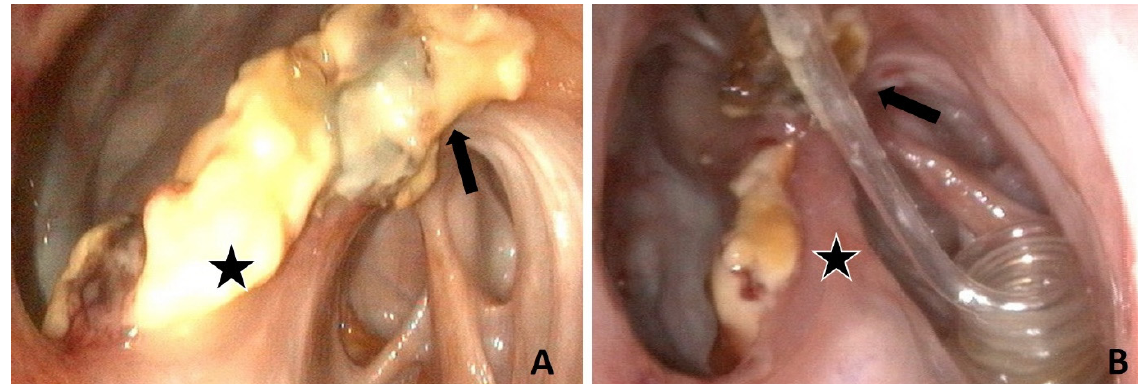
Figure 6. Endoscopic evaluation of Horse 6, right GP (guttural pouch): ( A ) at admission, macroscopic inflammatory lesions located on the stylohyoid bone (star) and the roof the medial compartment with regard to the ICA (internal carotid artery) (arrow); ( B ) after 9 days of TOT (topical oxygen therapy) and a TACE (transarterial coil embolization) procedure, the volume occupied by the macroscopic inflammatory lesion is reduced. The spiraled tip of the GP catheter is present in the medial compartment.